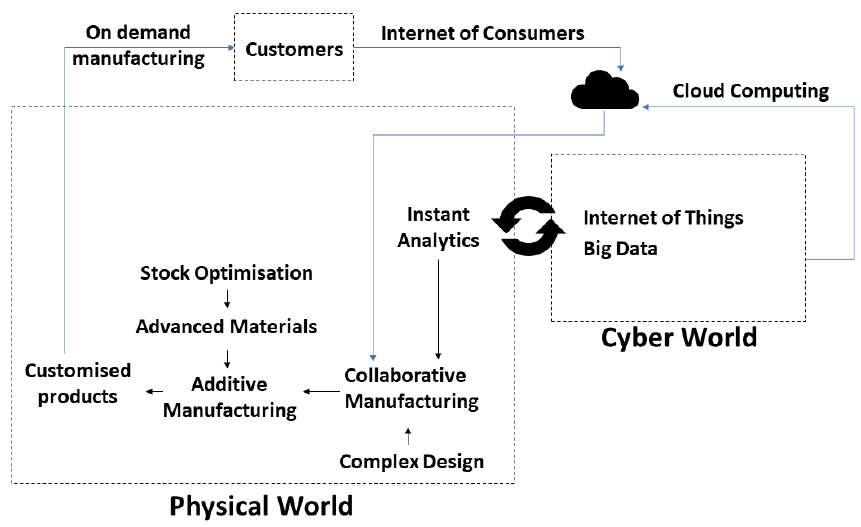
Figure 2. Smart factories schematics with general properties in Industry 4.0.